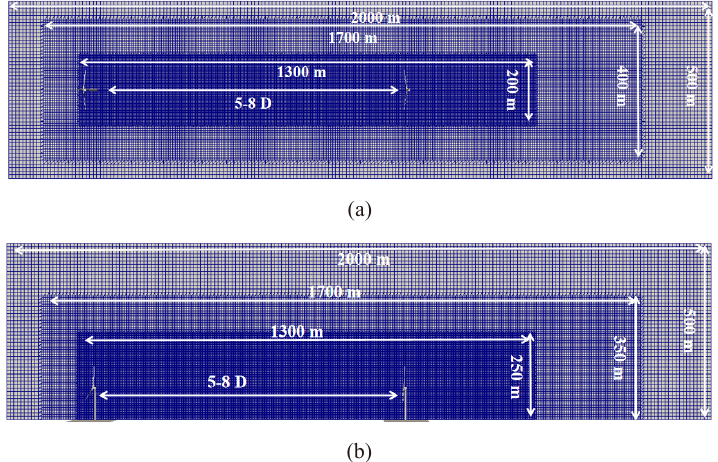
Figure 4. Schematic diagrams and grids of the calculation domain: ( a ) Top View; ( b ) Side